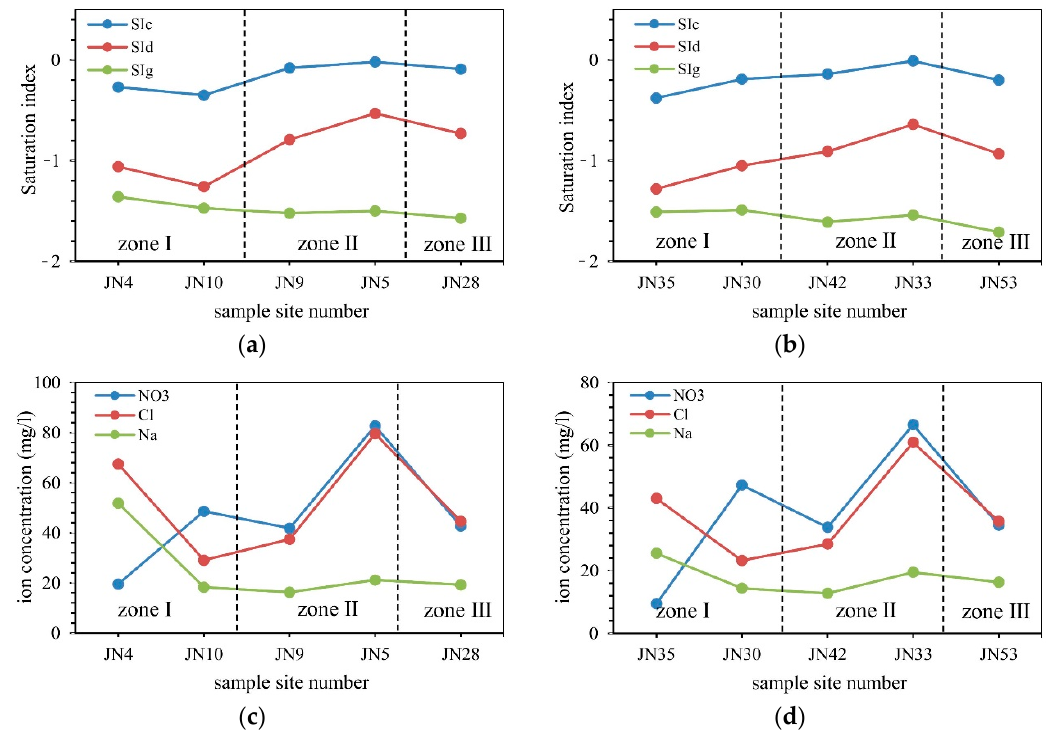
Figure 10. The variation of SIc, SId, SIg, NO 3 , Cl, and Na along the flow path of river water recharge (zone I, zone II, and zone III were obtained from the cluster analysis from Figure 9). ( a ) the variation of SIc, SId, SIg along the flow path in May, ( b ) the variation of SIc, SId, SIg along the flow path in October, ( c ) the variation of NO 3 , Cl, and Na along the flow path in May, ( d ) the variation of NO 3 , Cl, and Na along the flow path in October.